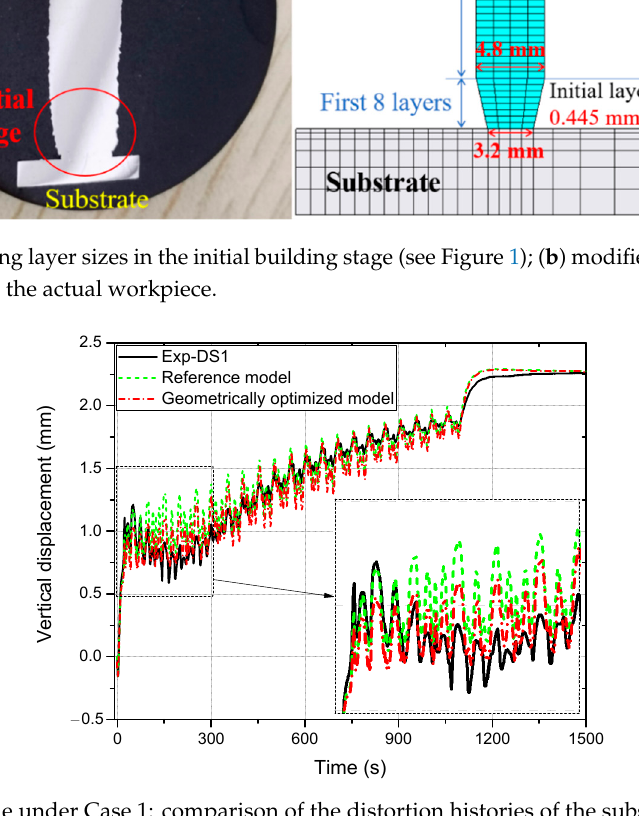
Figure 6. Rectangle under Case 1: comparison of the distortion histories of the substrate between the reference simulation and the upgraded model.